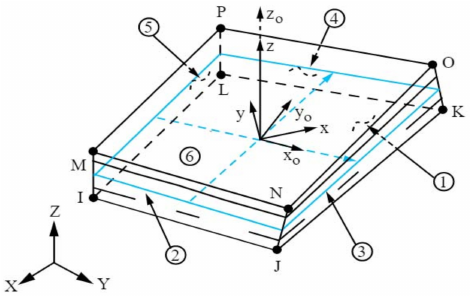
Figure 4. Schematic diagram of element SOLSH190